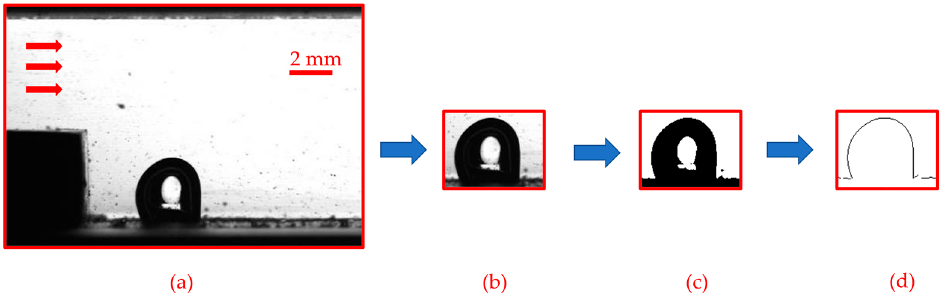
Figure 6. Image processing process (Take the picture under the typical working condition of Re = 4000 as an example.). ( a ) Original image; ( b ) background subtraction and grayscale processing; ( c ) binarization process; ( d ) edge detection and image fill.